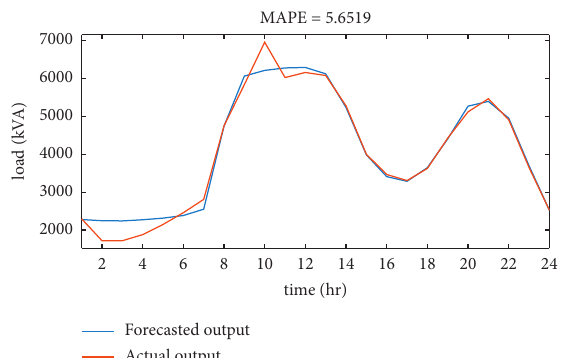
Figure 16: The Fuzzy-PSO prediction of Epiphany load.